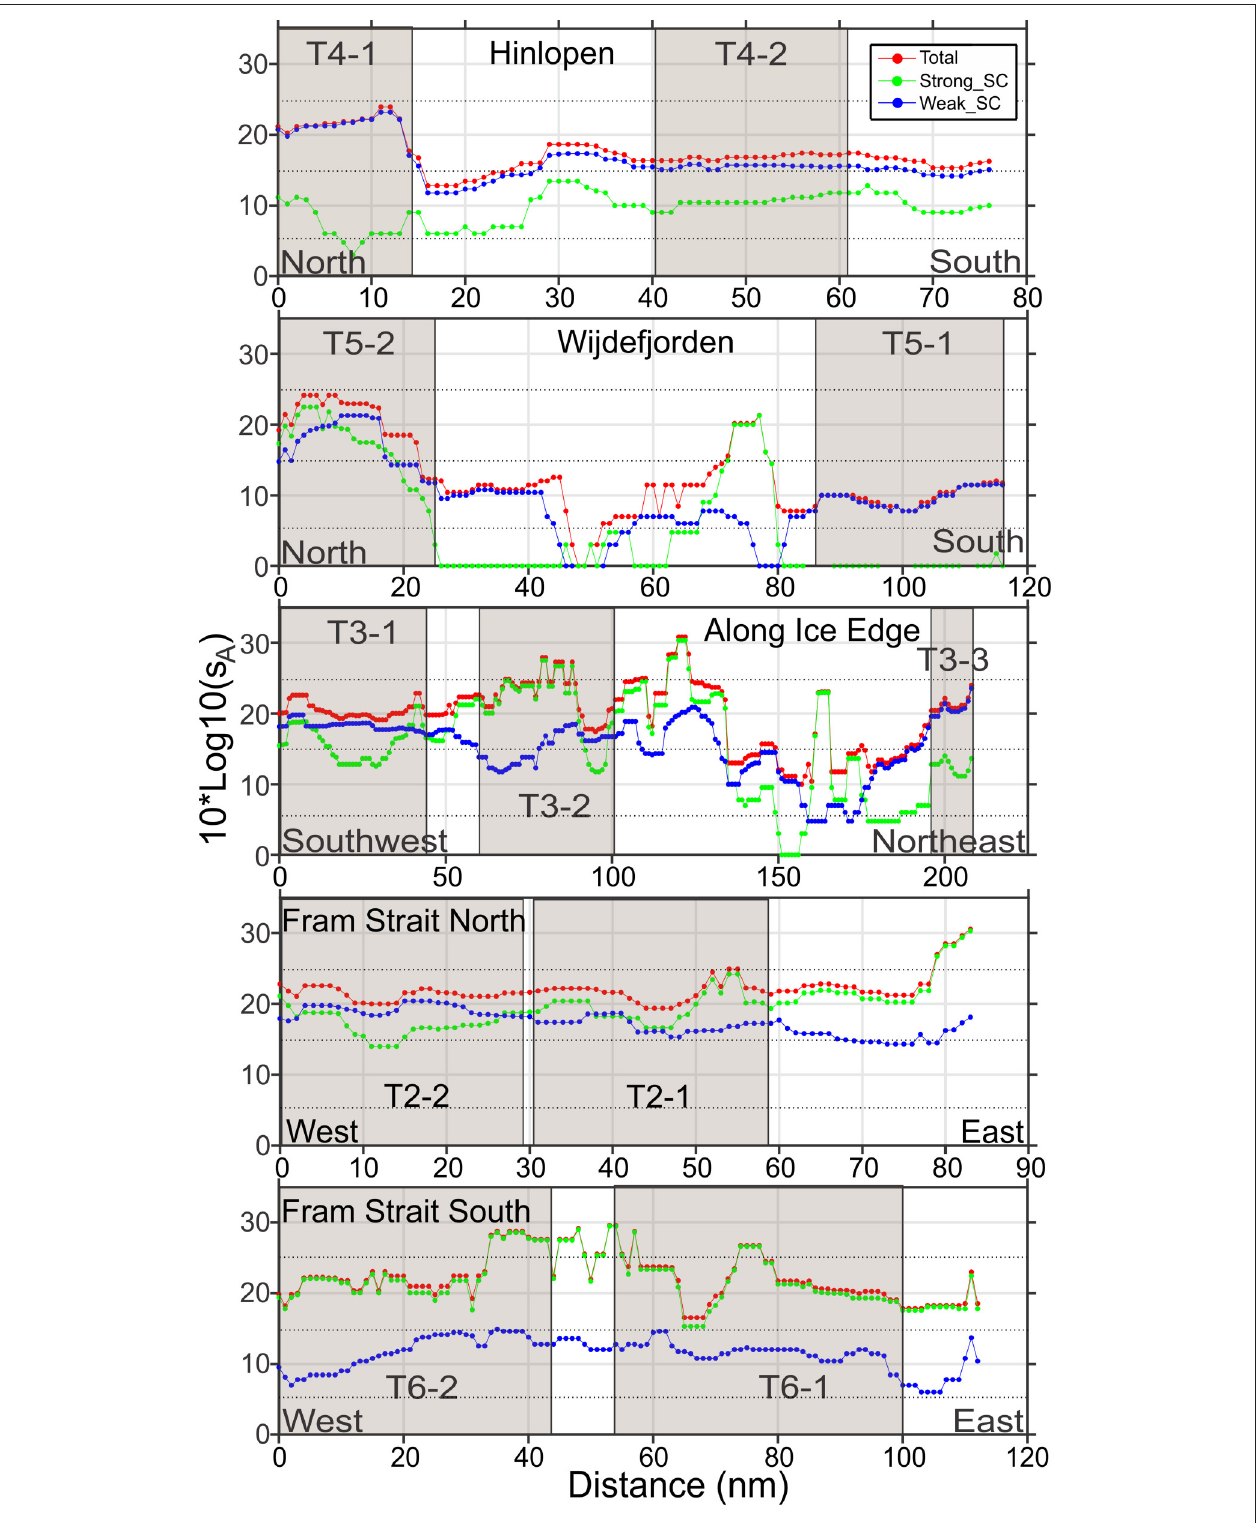
FIGURE 5 | Vertically integrated s A, Nautical area scattering coefficient in units of (m 2 nmi − 2 ) presented as Nautical area scattering strength, S A = 10*Log10 (s A ), dB re 1(m 2 nmi − 2 ) along transects, arranged from south-west (lower) to north-east (upper): T6, Fram Strait South; T2, Fram Strait North; T3, Along Ice Edge; T5, Wijdefjorden; T4, Hinlopen. Beige boxes indicate position of subsections. x-axes are of unequal length.